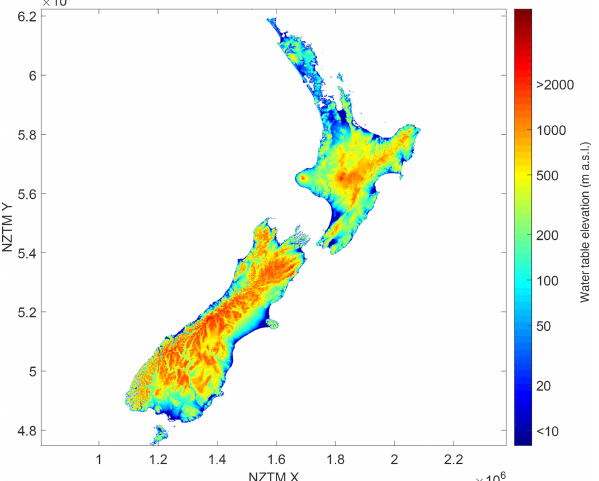
Figure 5. NWT water table elevation in New Zealand.